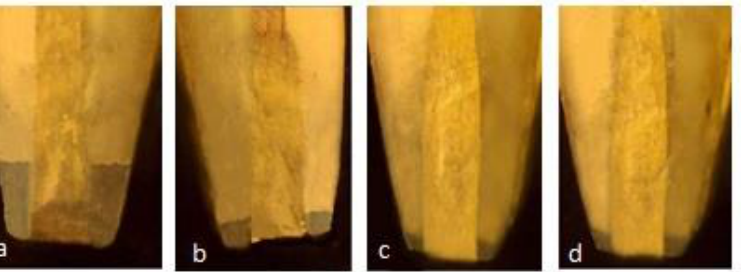
Figure 1. Stereomicroscopic images of leakage in different group at 15 days ( a ) GIC (1.23 mm) ( b ) Proroot MTA (0.45 mm) ( c ) Neo MTA plus (0.08 mm) ( d ) BIODENTINE (0.10 mm).